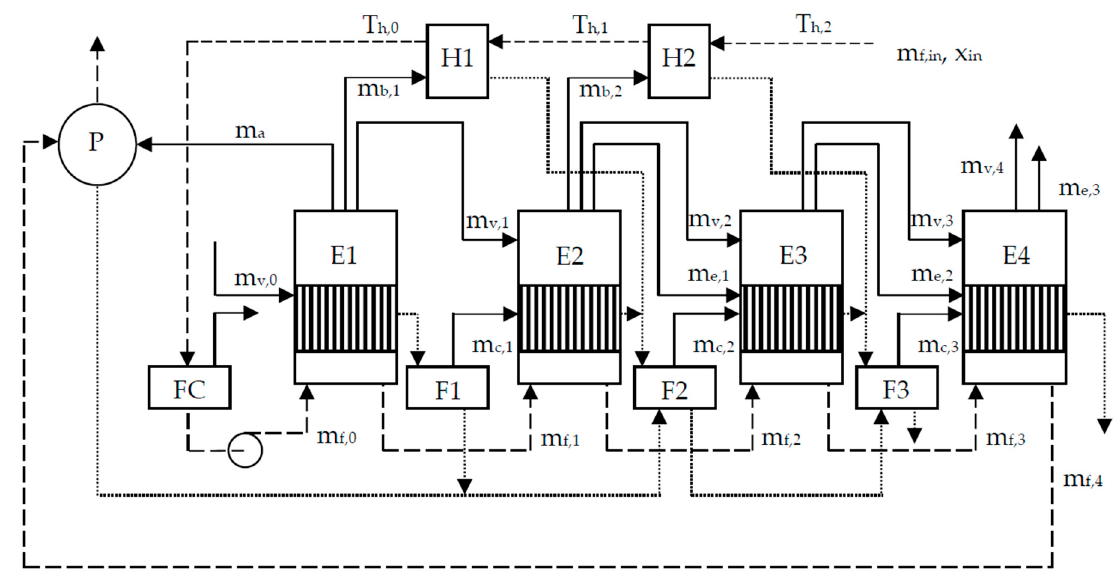
Figure 1. Conventional evaporation process .